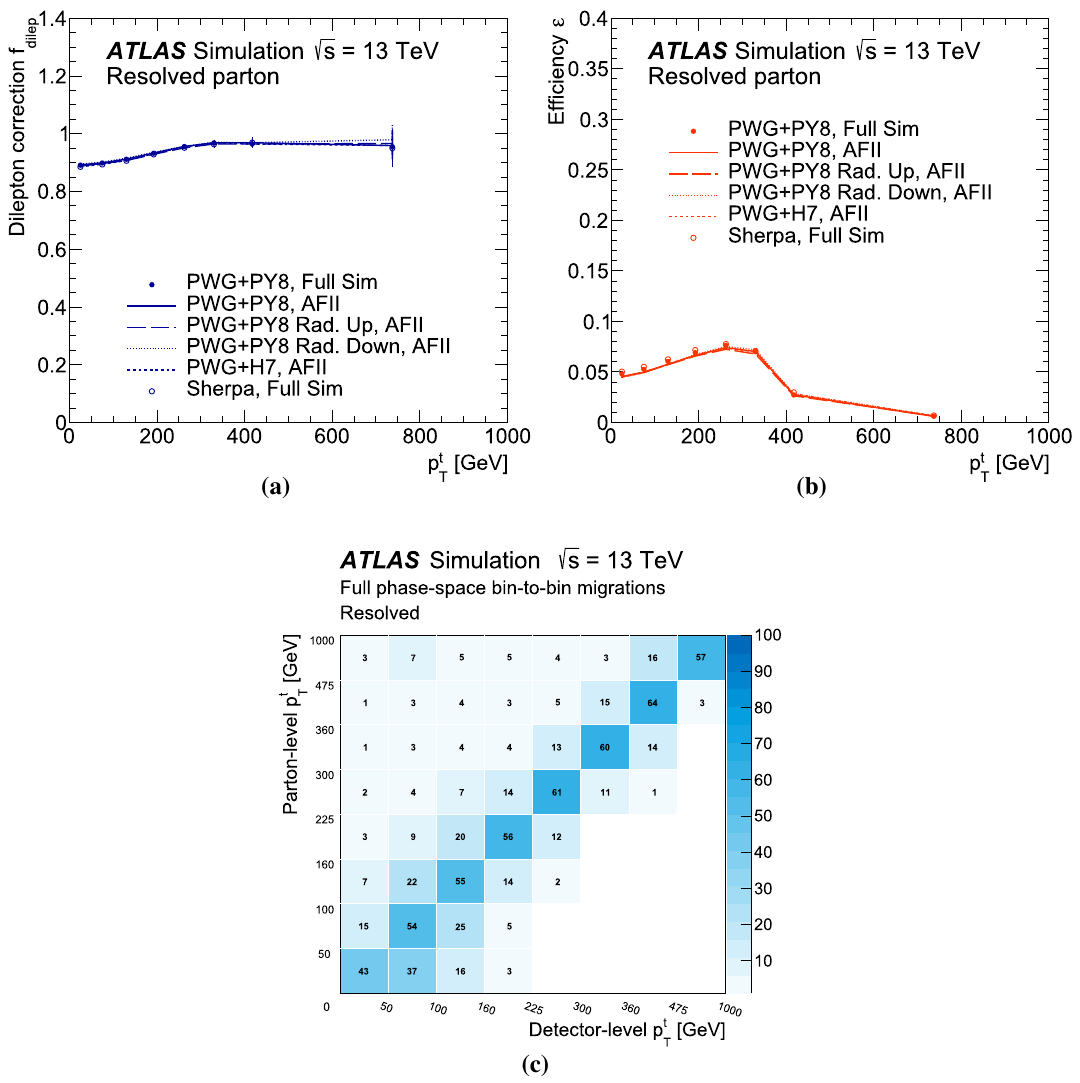
Fig. 15 The a dilepton f dilep and b efficiency ε corrections (evalu- ated with the Monte Carlo samples used to assess the signal modelling uncertainties, as described in Sect. 9.2), and c the migration matrix